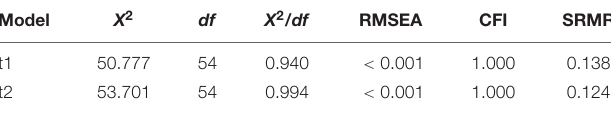
TABLE 1 | Fit indices of confirmatory factor analysis (CFA) with a single-factor